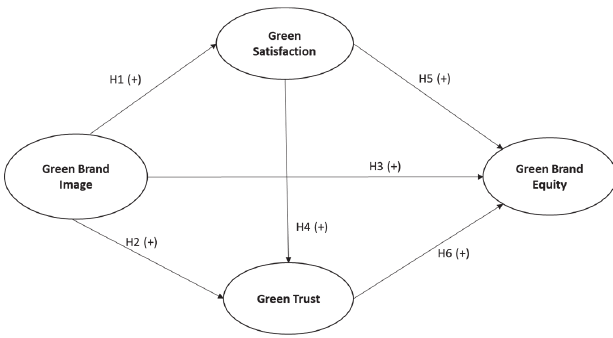
Fig. 1. Hypothesized